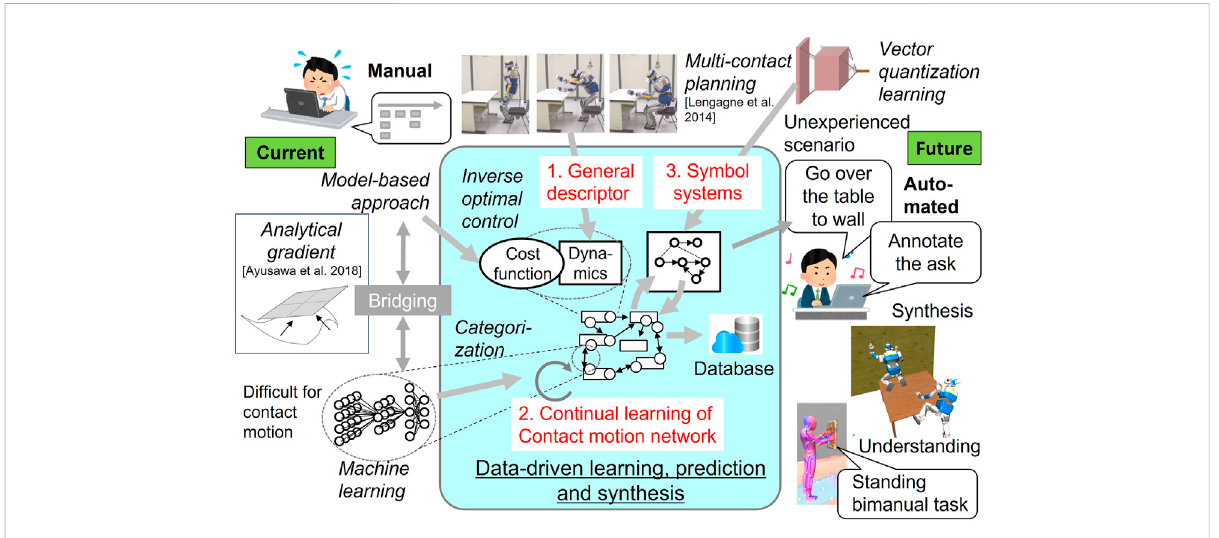
FIGURE 3 Current technologies (noted in italics ) to tackle the challenges and expected outcomes of this research. The analytical gradient bridges the model-based approach and machine learning to obtain the contact motion network. Symbolic representation is obtained based on vector quantization (VQ) learning for high-level automatic understanding and synthesis of contact motions instead of manual annotation and